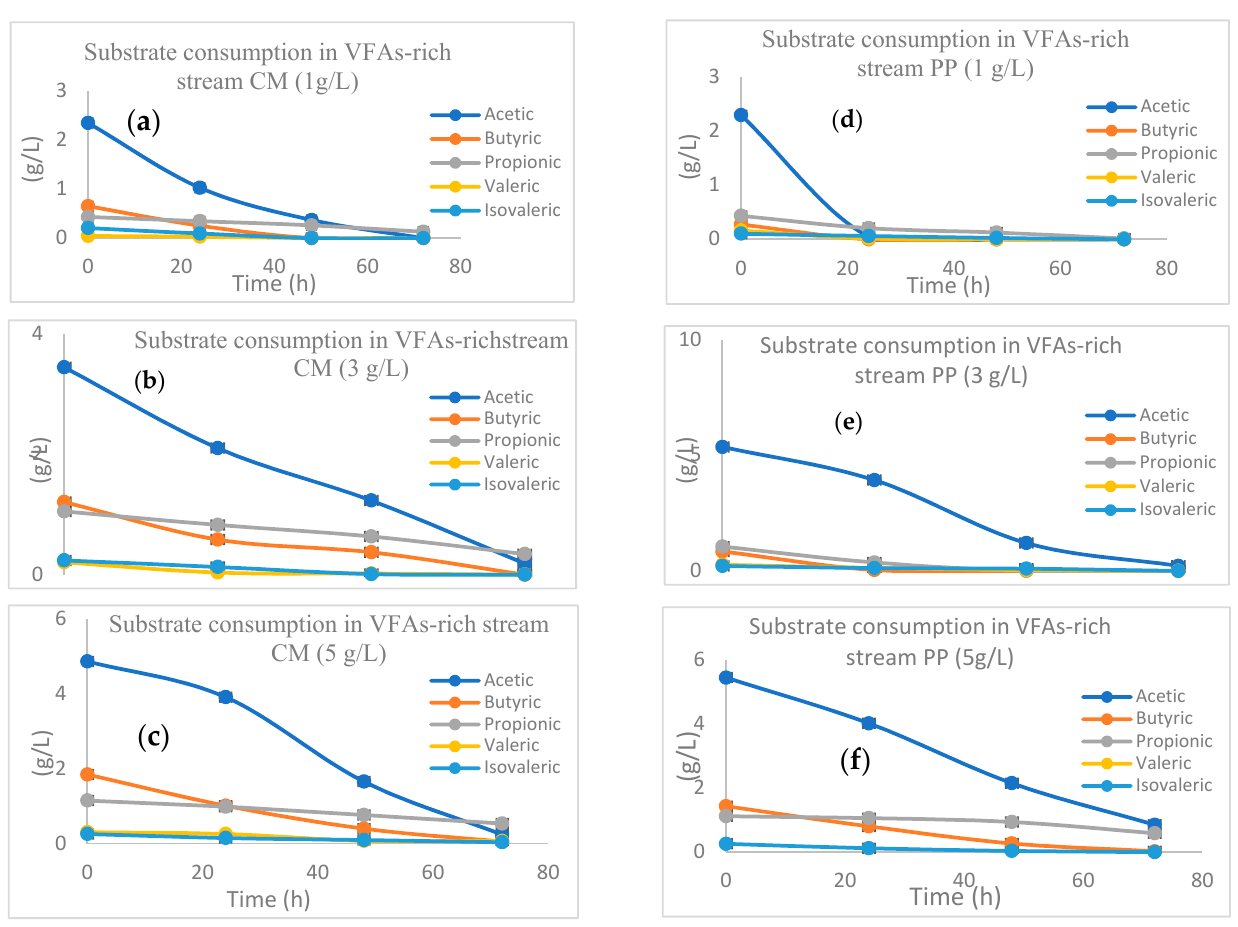
Figure 3. Substrate consumption in ( a ) VFAs-CM; 1 g/L ( b ) VFAs-CM; 3 g/L ( c ) VFAs-CM; 5 g/L; ( d ) VFAs-PP; 1 g/L ( e ) VFAs-PP; 3 g/L and ( f ) VFAs-PP; 5 g/L during P. oleovorans cultivation. Abbreviations: VFAs-CM = Volatile fatty acid stream from Chicken manure; VFAs-PP = Volatile fatty acid stream from Potato peels, and the PP and CM percentages are 45 and 47%,